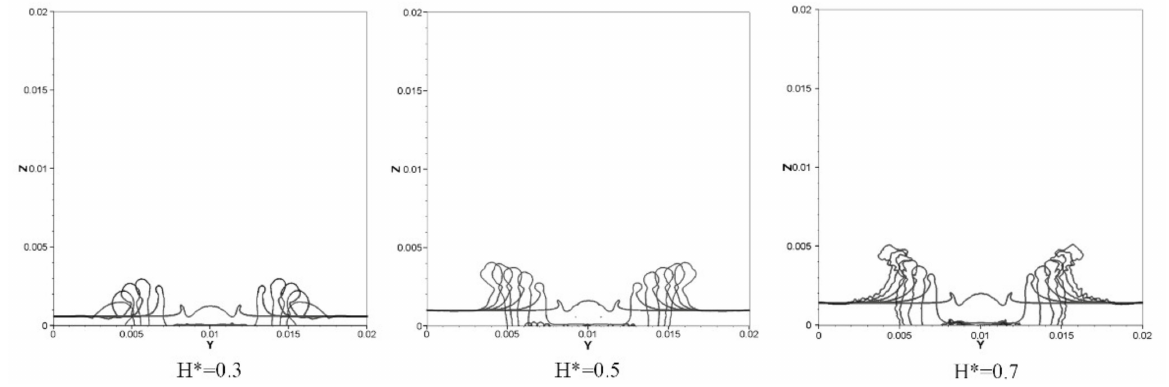
Figure 10. The evolution of x = 0.01 m section of the crown at different